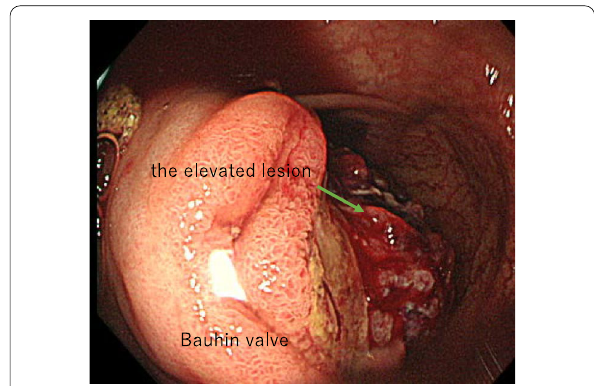
Fig. 2 Lower gastrointestinal endoscopy findings. It is a hemorrhagic elevated lesion located near the Bauhin